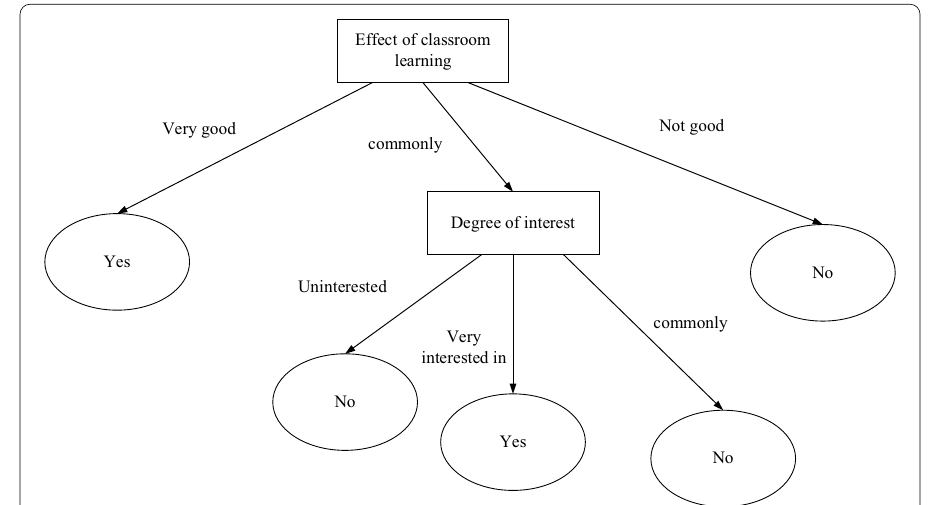
Fig. 4 The result of the pruning of a decision